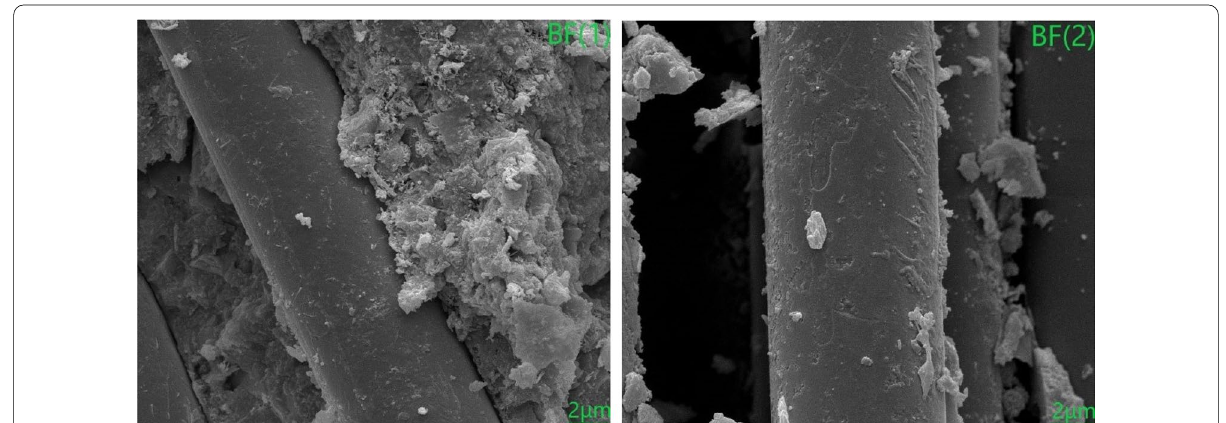
Fig. 10 The SEM of basalt fiber subjected to 20 times of single-side salt-freezing–drying–wetting cycles.